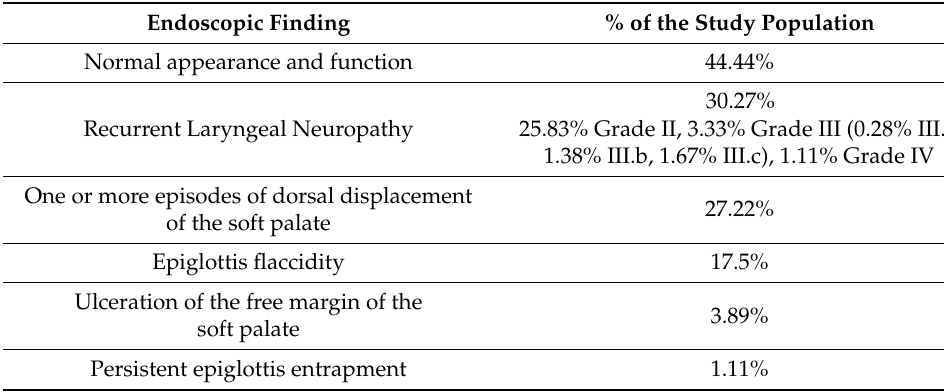
Table 2. Distribution of upper airways endoscopic findings at